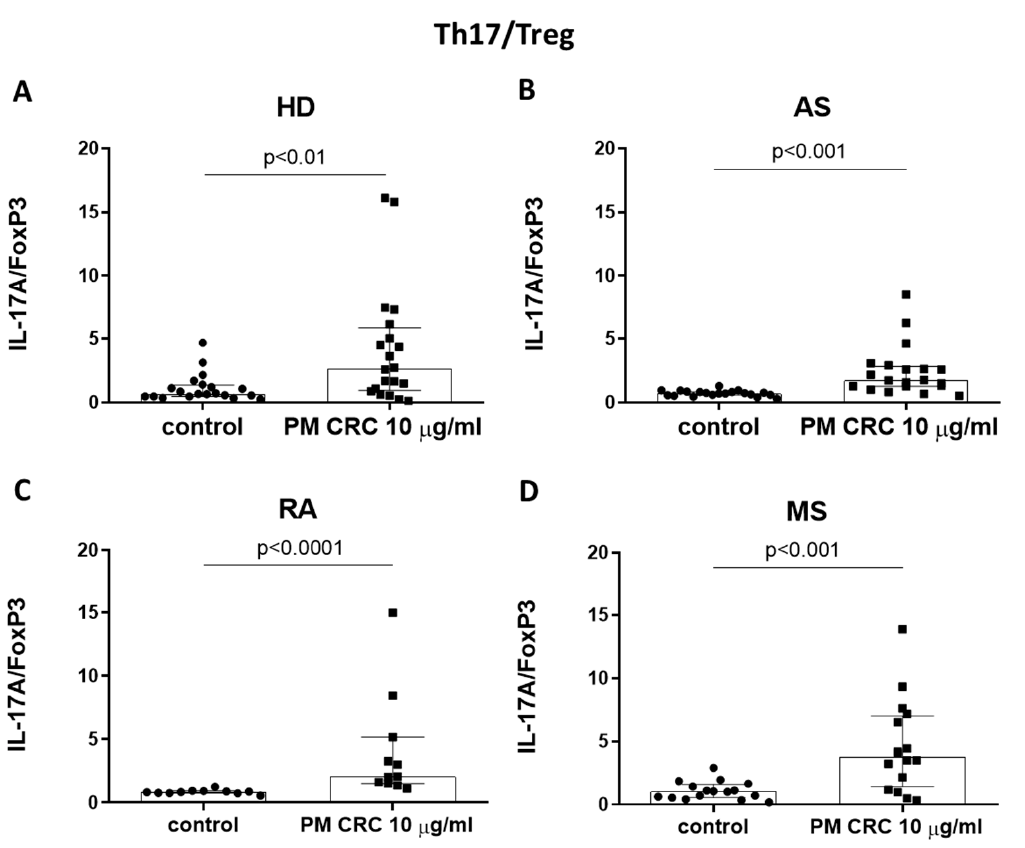
Figure 2. Effect of the exposure of PBMCs to PM CRC on the ratio of Th17/Treg cells in patients and HD. After PBMCs stimulation, the proportion of CD4 + cells positive for IL-17 (Th17) and FoxP3 (Treg), and the corresponding Th17/Treg ratio were determined in HD ( A ) and patients with AS ( B ), RA ( C ), and MS ( D ). Data are presented as median ± interquartile range from 20 independent experiments for HD ( A ) and AS ( B ), 11 for RA ( C ), and 16 for MS ( D ). Differences between the groups were considered statistically significant at p < 0.05.